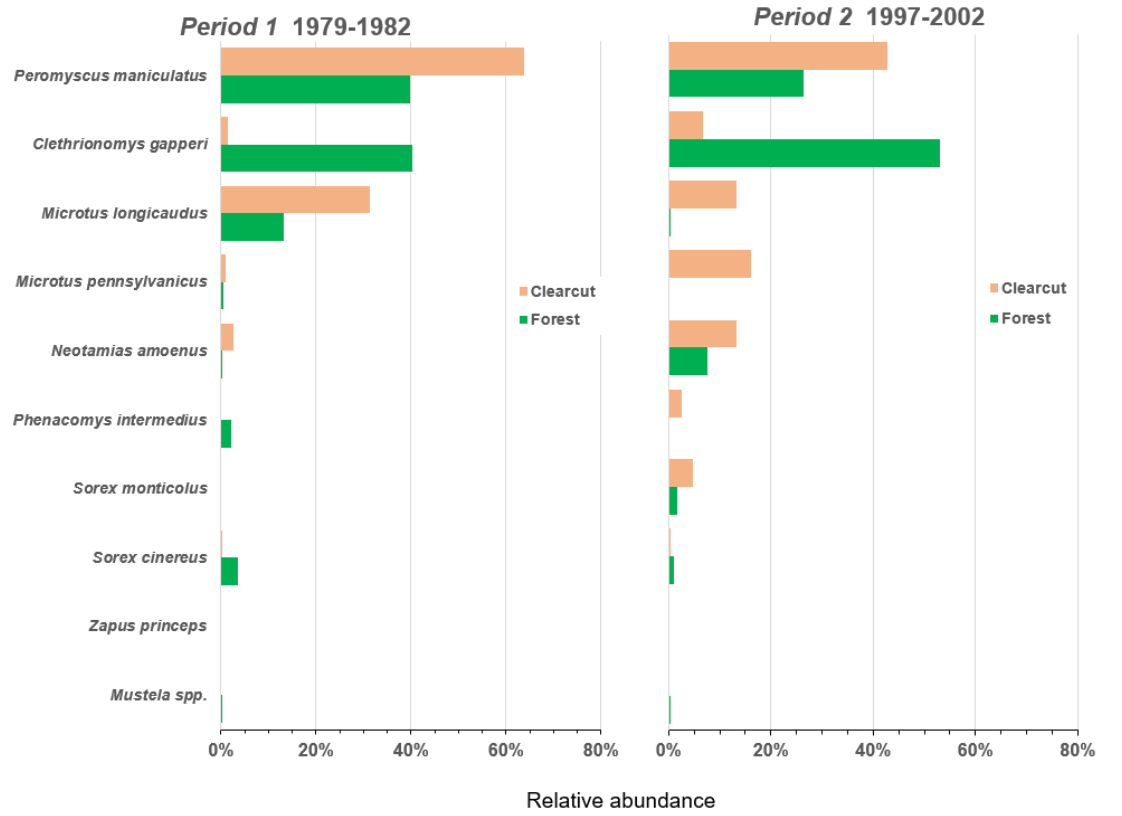
Figure 4. Relative abundance of nine species in the small mammal community in Periods 1 to 2 (1979 – 1982 and 1997 – 2002) in clearcut and forest sites for the CC-FOR study in southern British Columbia, Canada.